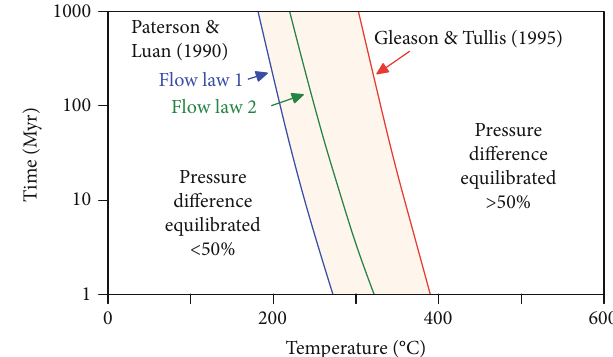
Figure 1: Time for a spherical fl uid- fi lled inclusion to reach 50% : pressure equilibration, starting with a hydrostatic pressure ð 5 Þ (assuming ρ fluid = 1000 kg/m 3 ) in a quartz matrix at lithostatic pressure (assuming ρ matrix = 2750 kg/m 3 ). The geotherm is set at 30 ° C/km at a surface temperature of 15 ° C. Flow laws used are from Paterson and Luan [41] and Gleason and Tullis [42] (see Table 1). Table 1: Parameters of the quartz fl ow law used in this study.